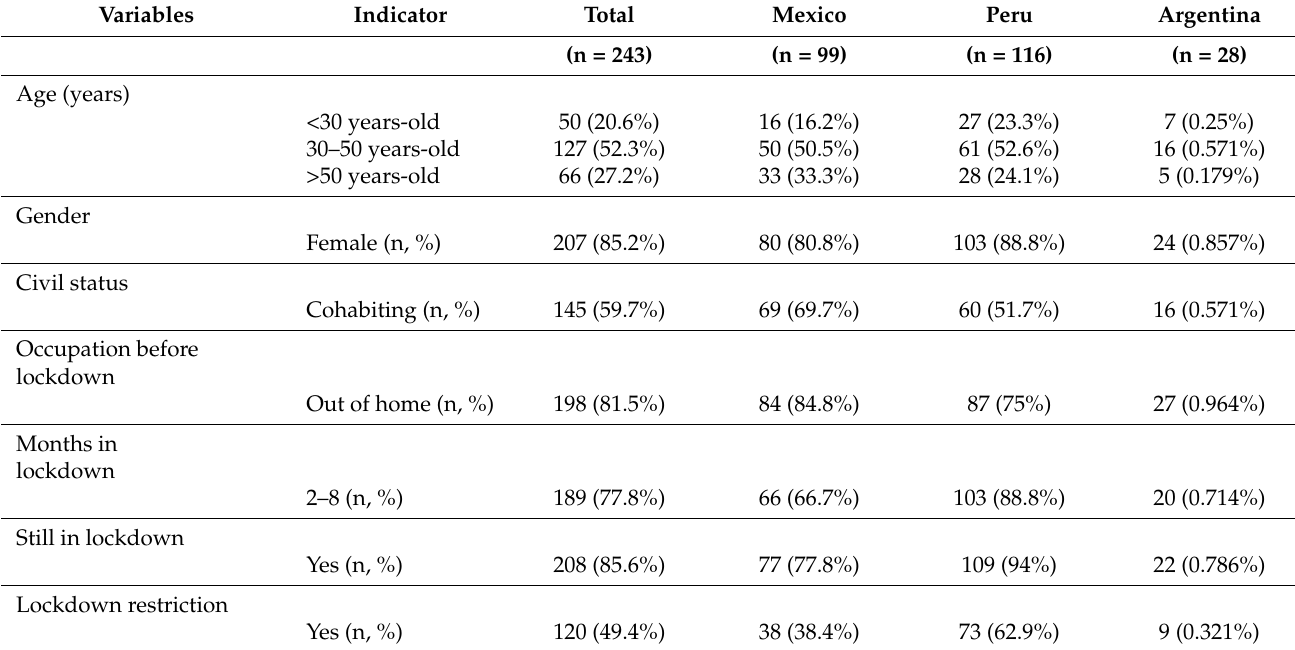
Table 1. Demographic of the respondents across Argentina, Mexico, and